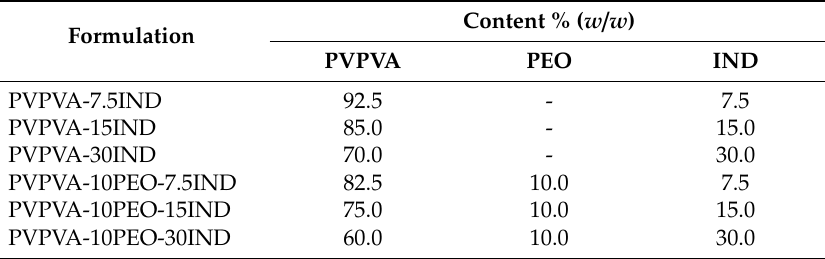
Table 1. Drug / carrier percentages of the HME processed